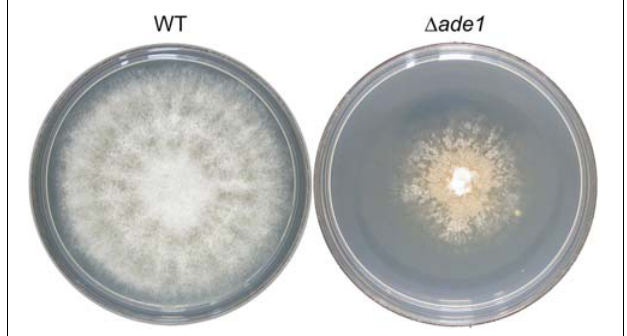
FIGURE 1 | Effect of ade1 deletion on colony morphology of Ophiostoma novo-ulmi after 7 days incubation on potato dextrose agar (PDA) at 21 ◦ C. The plate on the left is the parental strain, H327 (WT), and the plate on the right is a (cid:49) ade1